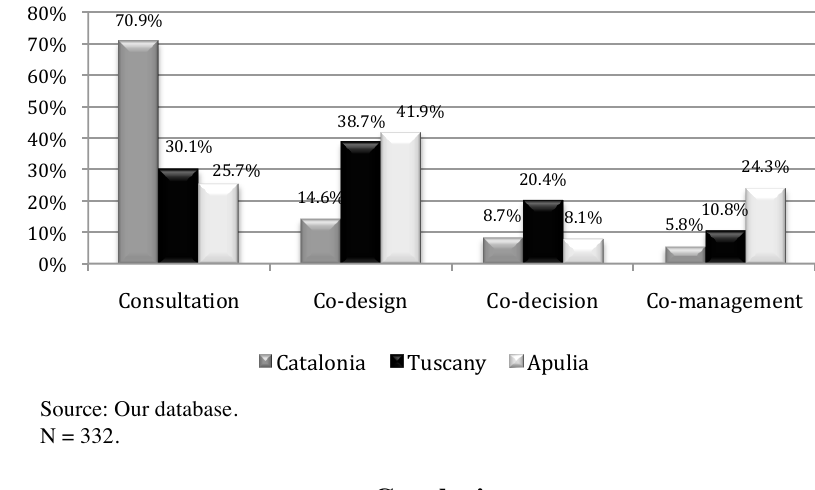
Graph 6. Level of intended influence of participatory processes, by